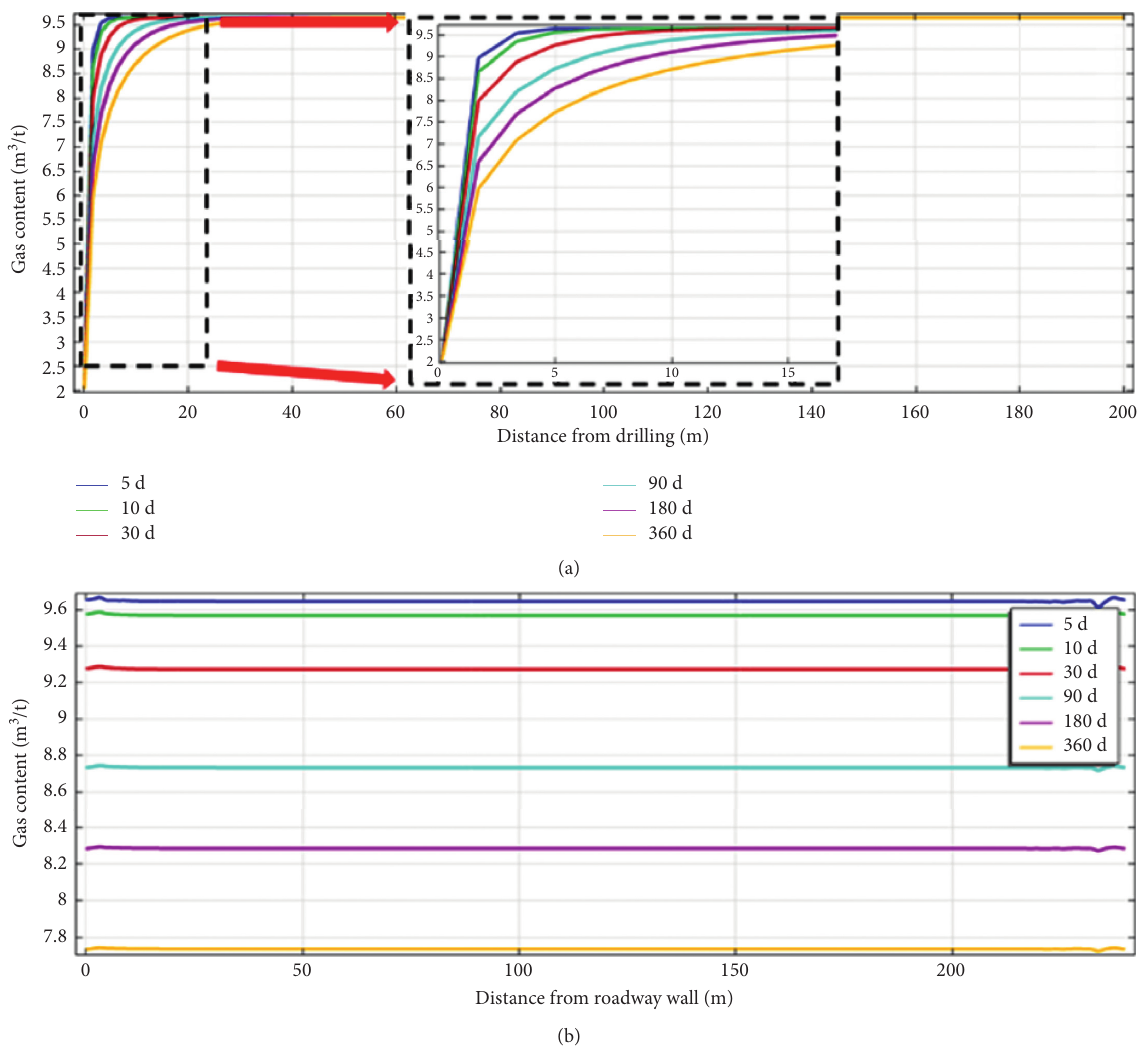
Figure 16: Distribution of gas content in 240m borehole with different drainage time: (a) gas content distribution on the monitoring line in the strike direction; (b) distribution of gas content in the trend direction monitoring